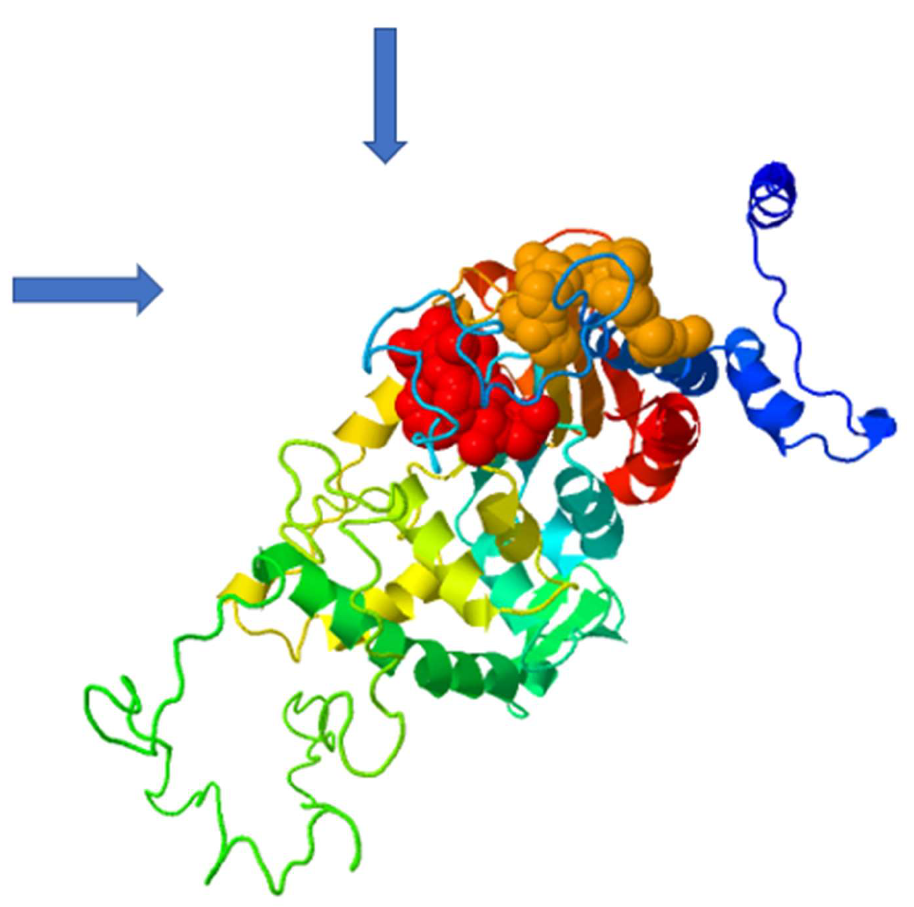
Figure 7. Structural prediction of two allosteric binding pockets (marked by blue arrows) predicted by the PASServer employing the 3D model of human DHS co=crystallized with the allosteric inhibitor. Binding Pocket 1 (red color) has the highest probability of 59.36% and a druggability score of 0.007. Pocket 2 (brownish color) has a probability score of 58.2% and a druggability score of 0.228.